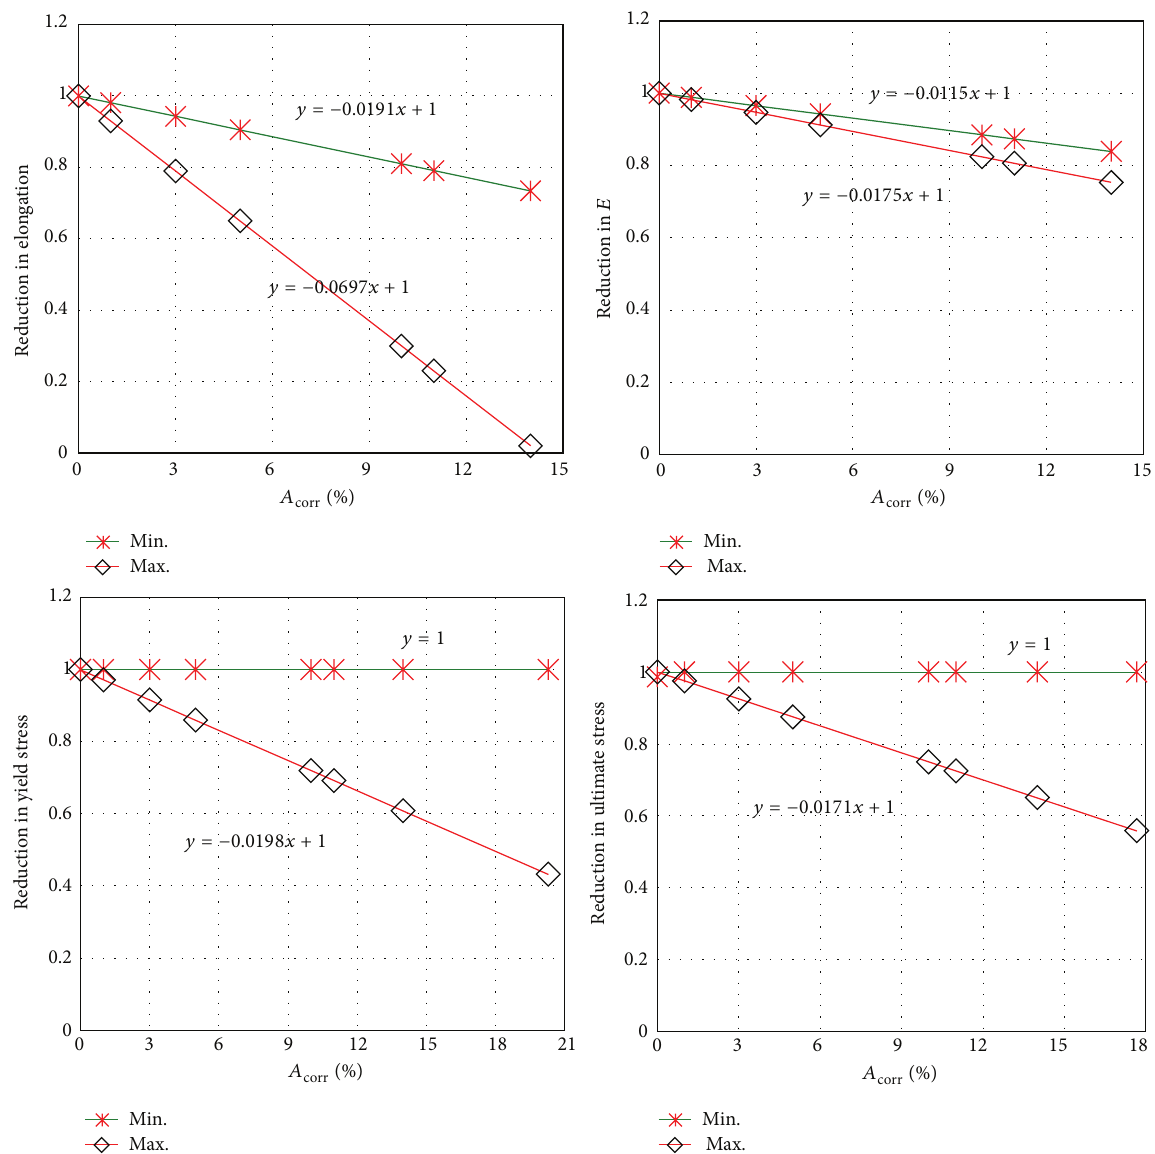
Figure 6: Maximum and minimum reduction factors for elongation, modulus of elasticity, yield stress, and ultimate stress.